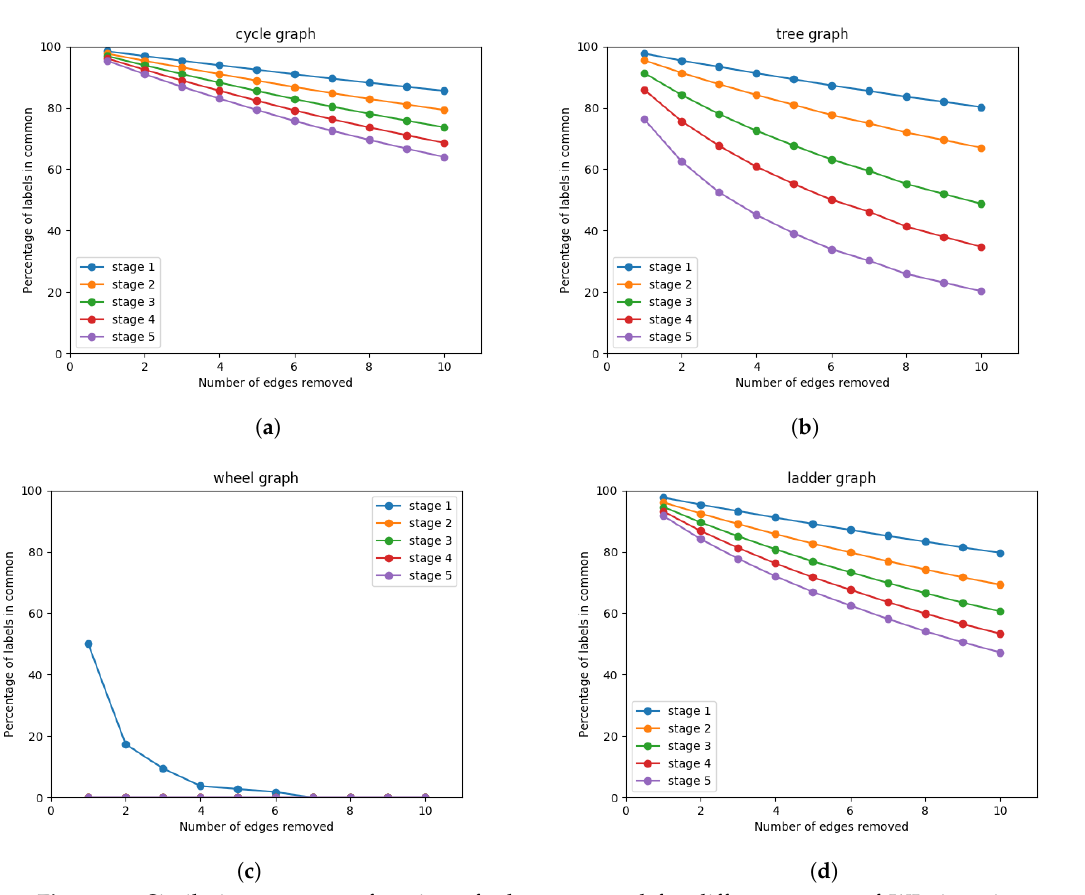
Figure 2. Similarity score as a function of edges removed for different stages of WL iterations. The similarity score reaches 100% for identical sets of labels, and 0% for disjoint sets of labels. ( a ) Cycle: the 2-regular graph with one giant connected component. ( b ) Tree: three children per node, except the ones at the last level. ( c ) Wheel: like cycle graph, with an additional node connected to all the others. ( d ) Ladder: two paths of 250 nodes each, where each pair of nodes is joined by an